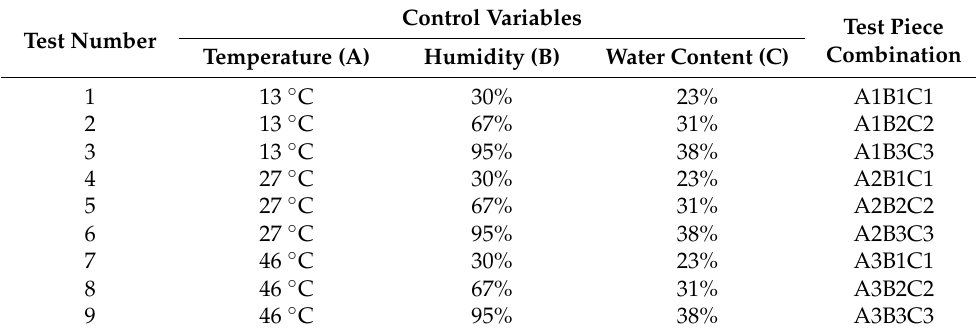
Table 2. Dry shrinkage test